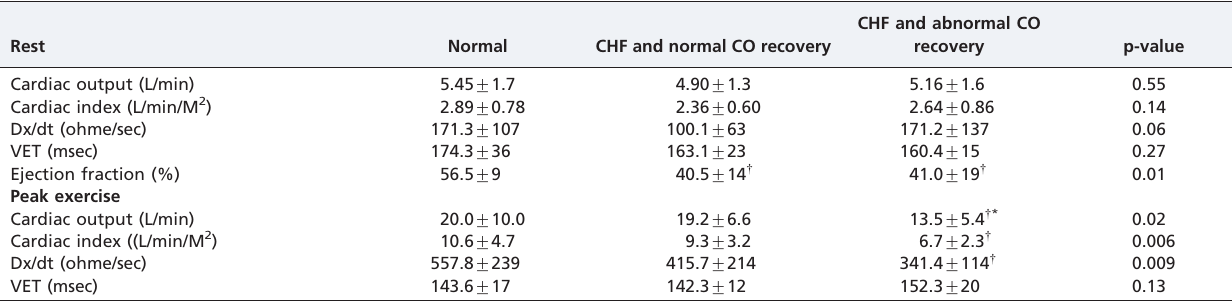
p-value represents ANOVA main effect between groups. *p , 0.05 vs. CHF and normal recovery. { p , 0.05 vs. normal subjects. Dx/dt=peak aortic flow. VET=ventricular ejection